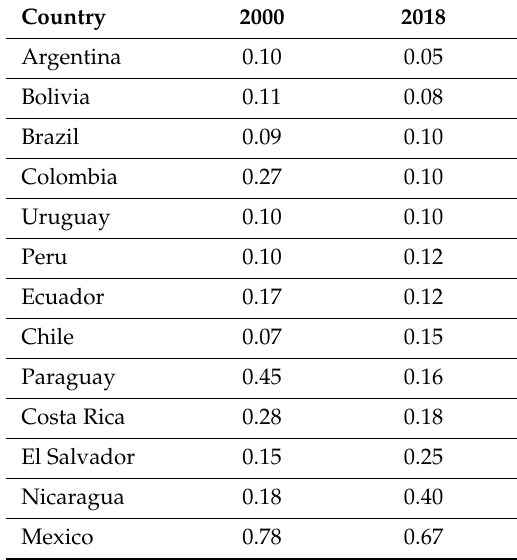
Table 4. Hirschman-Herfindahl Index (Trade Concentration Index) in Latin America.